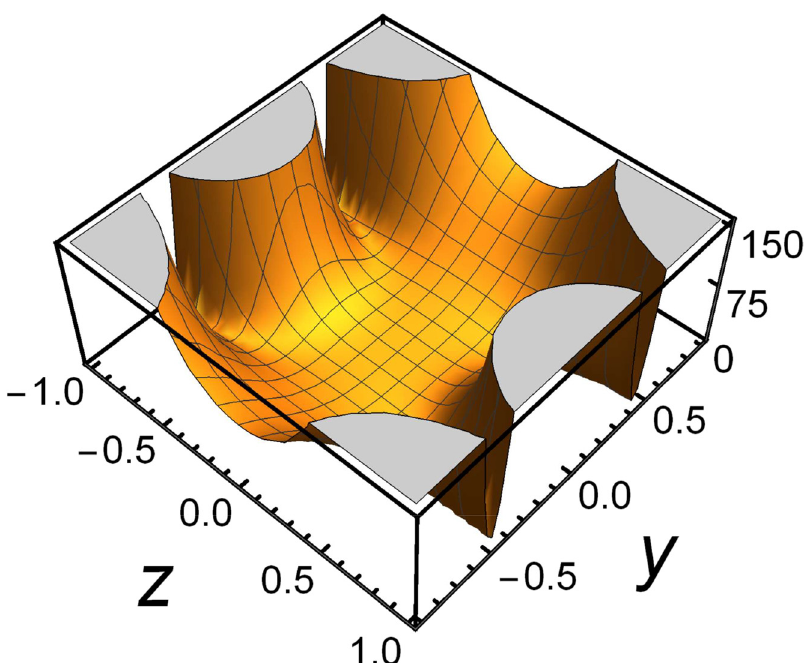
Figure 4: Near field of a system of two- metasurfaces; see Eq. (16). The 3D plot shows the square of the fi eld, Re 2 [ F ( y , z